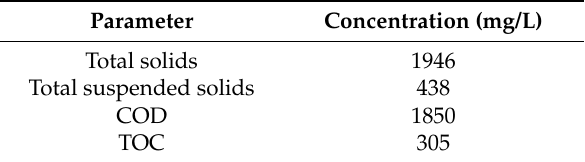
Table 7. Characterization of the olive mill wastewater used in the concentration test in terms of total solids, total suspended solids, chemical oxygen demand (COD), total organic carbon (TOC) and oil and grease.